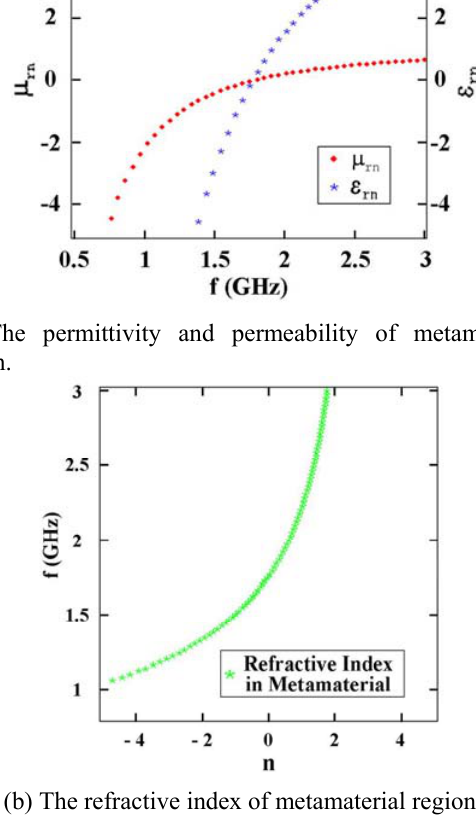
Figure 2: The permittivity, permeability and refractive index of metamaterial